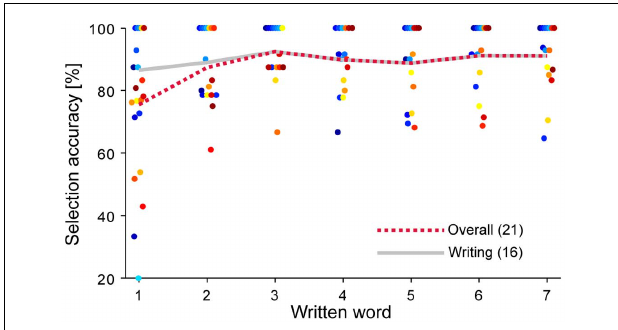
FIGURE 4 |Accuracy over time. Selection accuracy of Session 1 is plotted for each subject as a function of the word written, which approximates time.The gray line represents the mean over the subjects that finished the entire sentence, which shows no significant slope.The red dotted line represents the mean over all